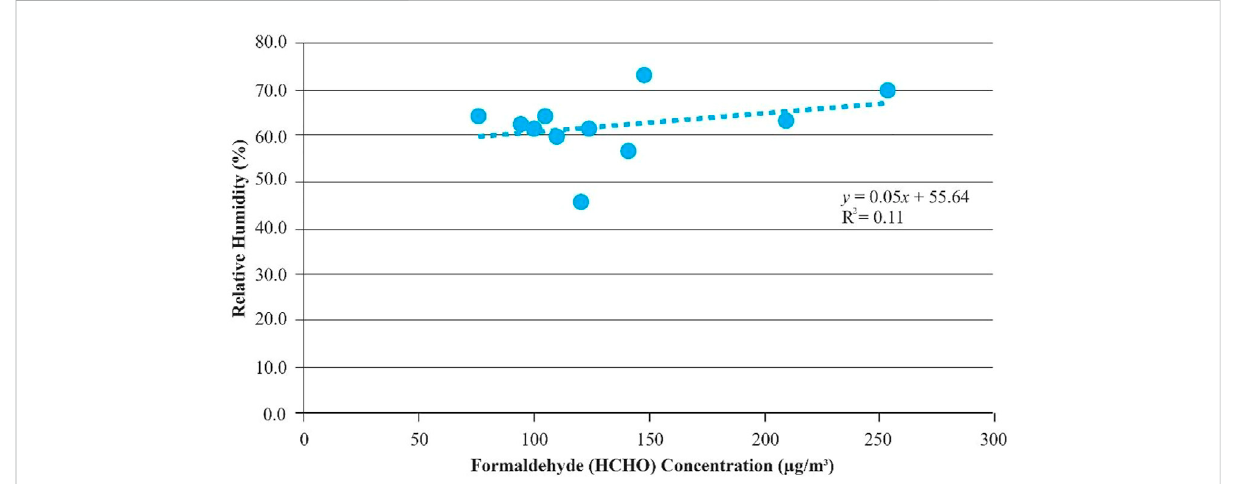
FIGURE 13 Relationship between formaldehyde (HCHO) concentration and humidity.